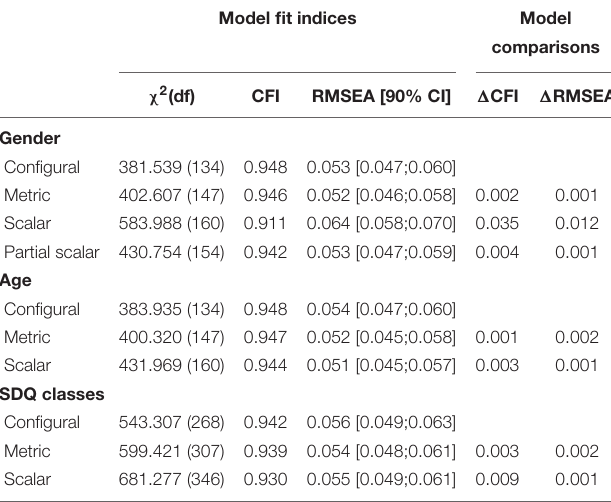
TABLE 1 | Results of measurement invariance tests by gender, age, and socio-emotional functioning